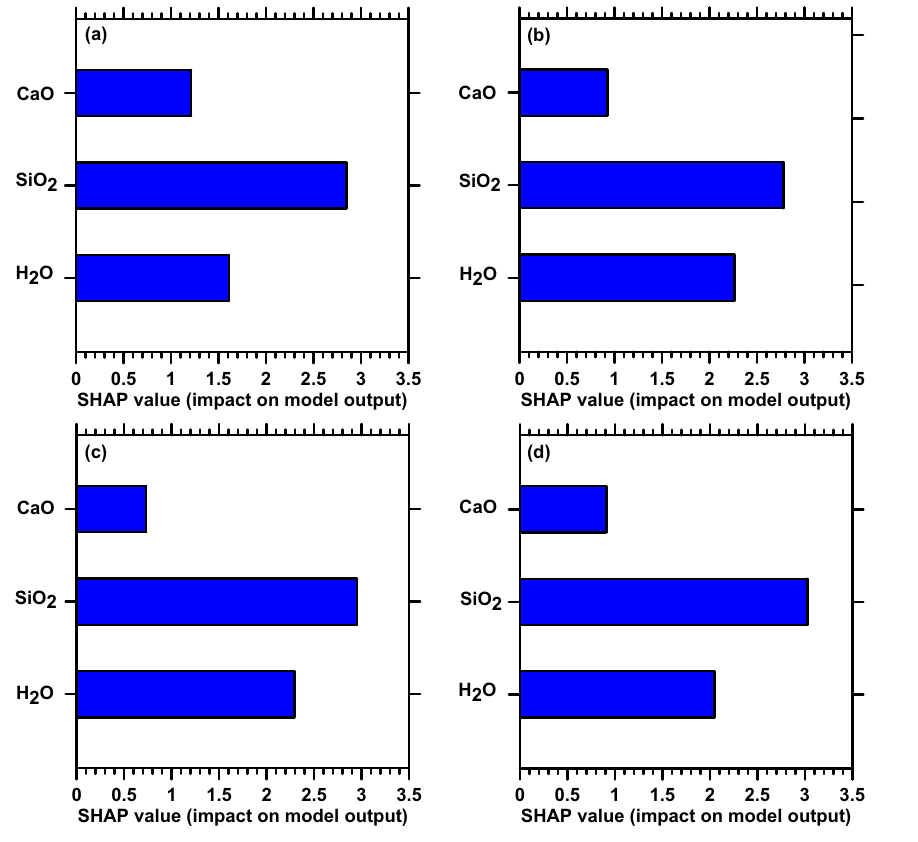
Figure 7. SHAP values for various compositions for ( a ) C 11 , ( b ) C 33 , ( c ) C 44 and ( d ) C 66